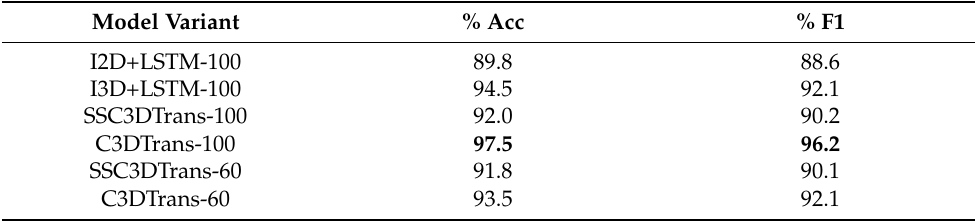
Table 6. Gesture-level results of the PT task. The best results column-wise are shown in bold.